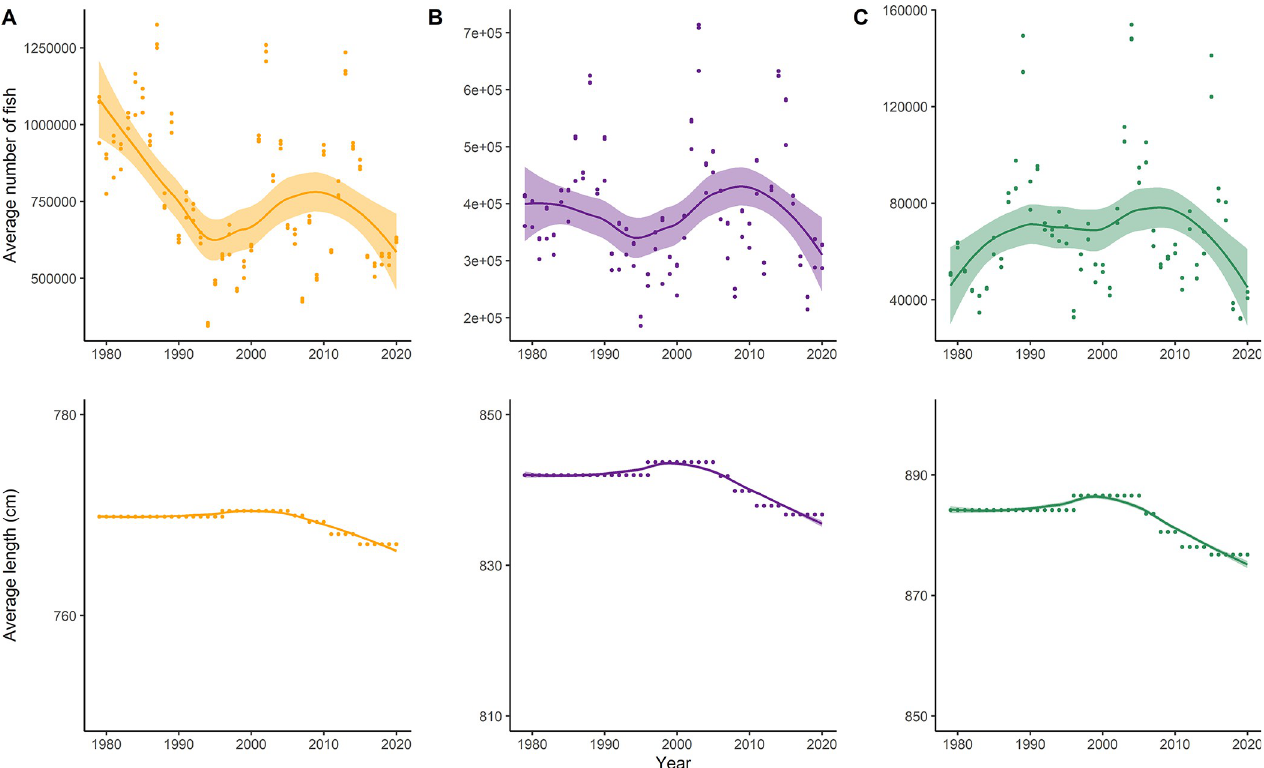
Fig 3. Average trend of abundance (top) and length-at-age (bottom) for age-3 (A), age-4 (B), and age-5 (C) Chinook salmon available to SRKW from 1979 to 2020 during the months April-October.